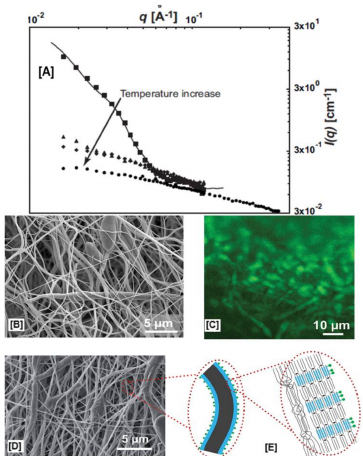
Figure 10. Temperature-dependent stability of pseudorotaxanes (PpR) using DMSO and an electron micrograph of electrospun core–shell nanofibers with PpR in the shell region, which was subsequently conjugated with FITC. The SANS analyses of the PpR (shell region) in DMSO showed decreases in scattering intensity, indicating dethreading of PpRs into α -CD and PCL phases. Whereas at 35 ◦ C, higher scattering intensity indicated the presence of a PpR structure, and in addition, a parallelepiped model was developed which showed CD assemblies approximating 11 α -CDs in length and 20 α -CDs in width ( A ). Additionally, conjugation of fluorescamine was only possible onto hydroxyl groups present in PpR ( B – E ), whereas in neat PCL nanofibers, conjugation was not possible. Images adapted and reproduced with permission from [104]. Copyright John Wiley and Sons